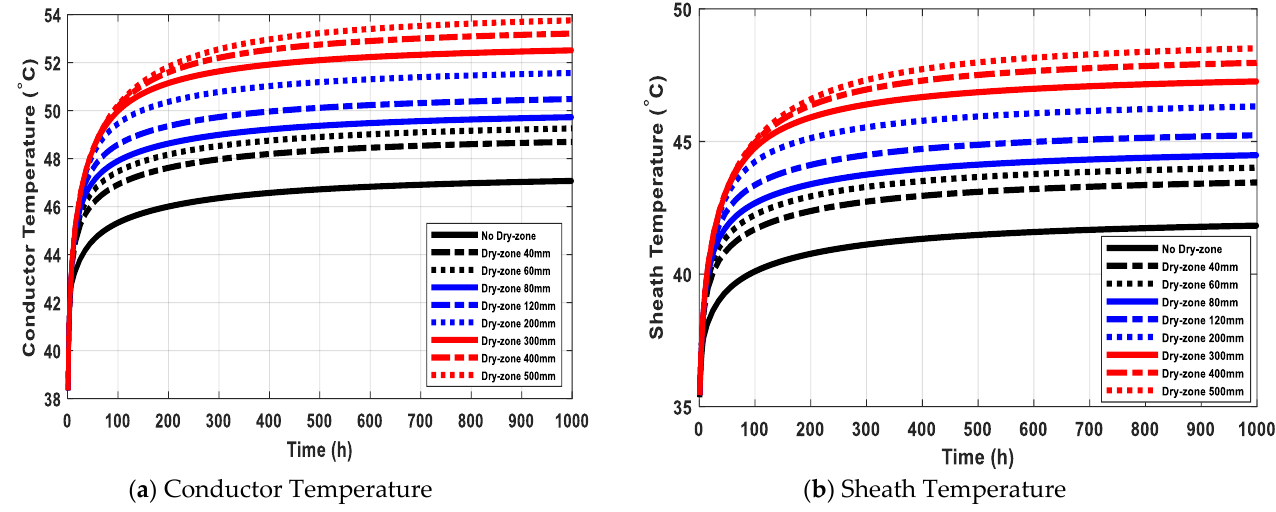
Figure 15. Impact of dry zone thickness on the temperature rise.